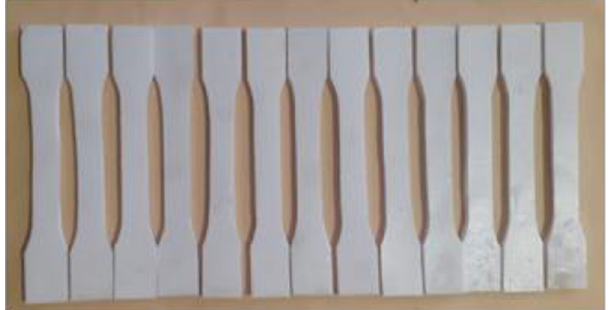
Fig. 3. Fabricated SIS specimen based on ASTM